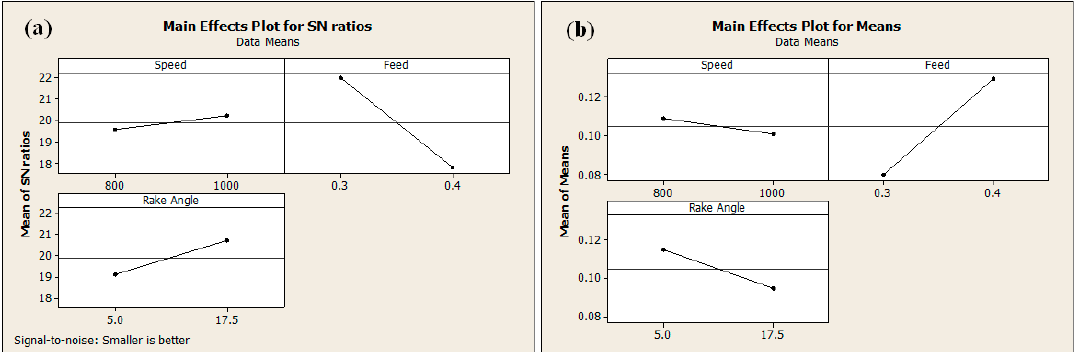
Figure 10. Variation of signal to noise (S/N) ratios ( a ) and data means ( b ) as a function of cutting parameters ( V C , f and γ ). Table 5. Response table for S/N ratios.